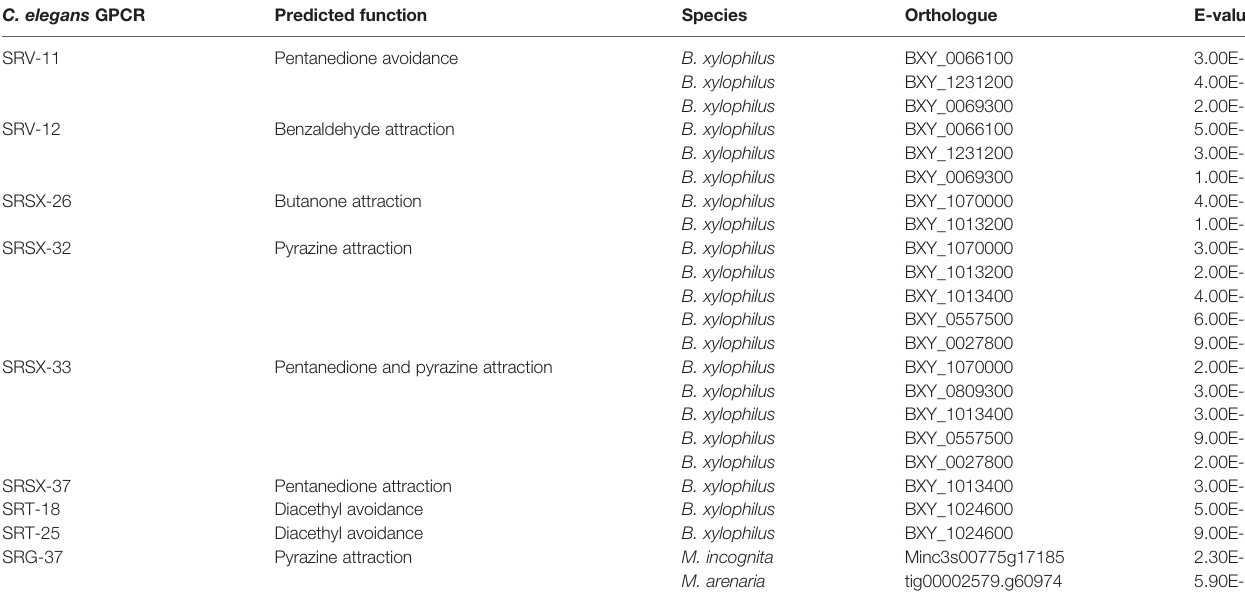
TABLE 3 | C. elegans olfactory receptor orthologues present in plant pathogenic nematodes, their predicted functions, and E-values of DNA sequence